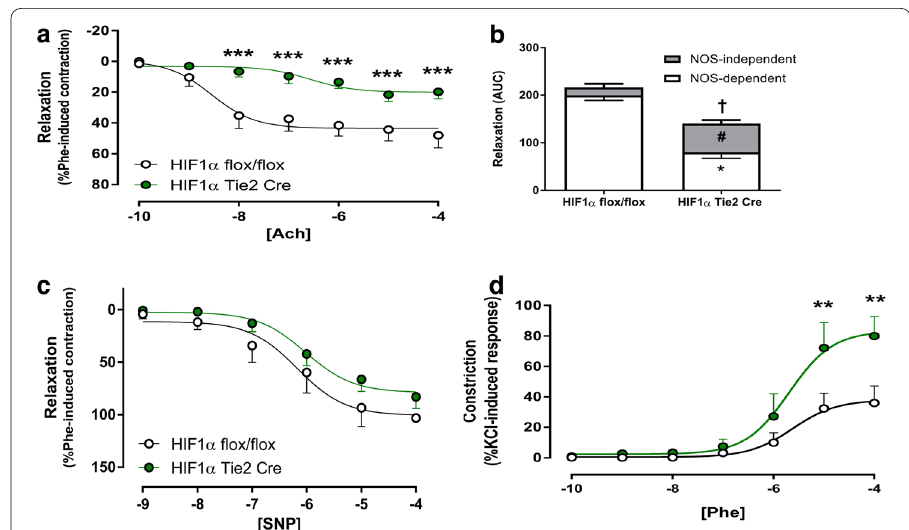
Fig. 2 Ex vivo assessment of femoral artery reactivity using wire myography in HIF-1α Tie2 Cre mice. Femoral artery reactivity was assessed using wire myography in HIF-1α Tie2 Cre (green, n 5) and HIF-1α flox/flox = littermates (grey, n 5). Data presented as Mean SEM. For concentration response curves, analysis was = ± by two-way ANOVA (* p < 0.05, ** p < 0.01, *** p < 0.001). The NOS-dependent/independent components expressed as area under the curve were analysed by One-way ANOVA with Tukey test (* p < 0.05 vs. NOS-dependent, # p < 0.05 vs. NOS-independent, † p < 0.05 vs. total effect). Data for the KCl, Phe and SNP area under the curve were analysed by the Student’s t test for unpaired data (* p < 0.05). a Degree of relaxation was expressed as a percentage of the contraction induced by phenylephrine. [ACh]: molar concentration of acetylcholine. b The contribution of NO-independent mechanisms was calculated by the AUC for ACh LNAME (10 − 5 M), * p < 0.05 for NO (Nitric Oxide) dependent and # p < 0.05 for NO-independent portions + of ACh-induced relaxation. c Degree of relaxation was expressed as a percentage of the contraction induced by phenylephrine. [SNP]: molar concentration of sodium nitroprusside and d degree of vasoconstriction developed in response to increasing molar concentrations of phenylephrine ([Phe] 10 − 5